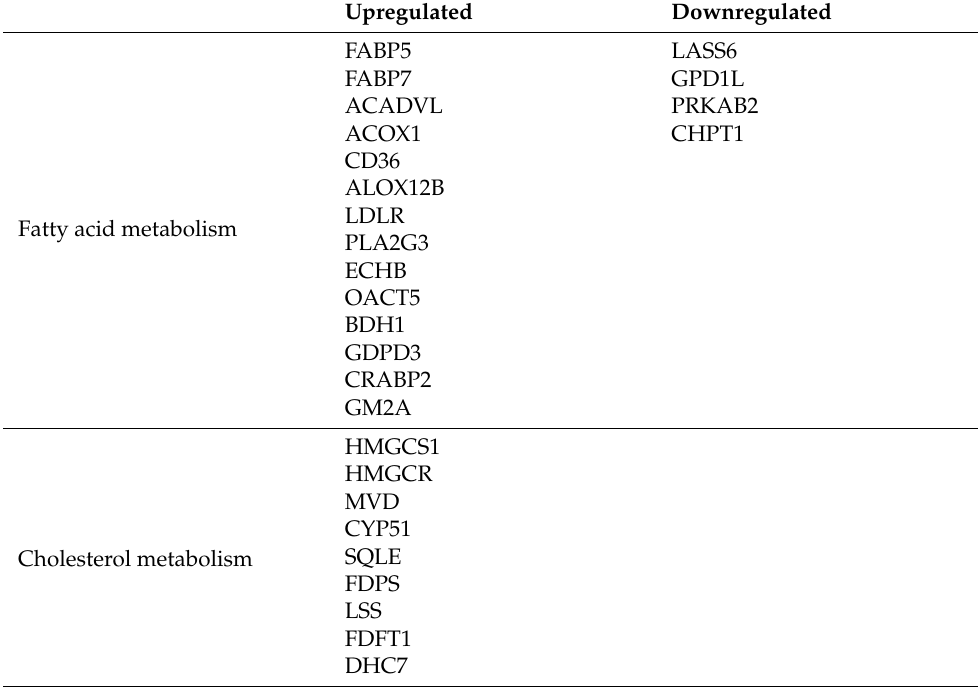
Table 2. PPAR δ target genes and associated pathways in